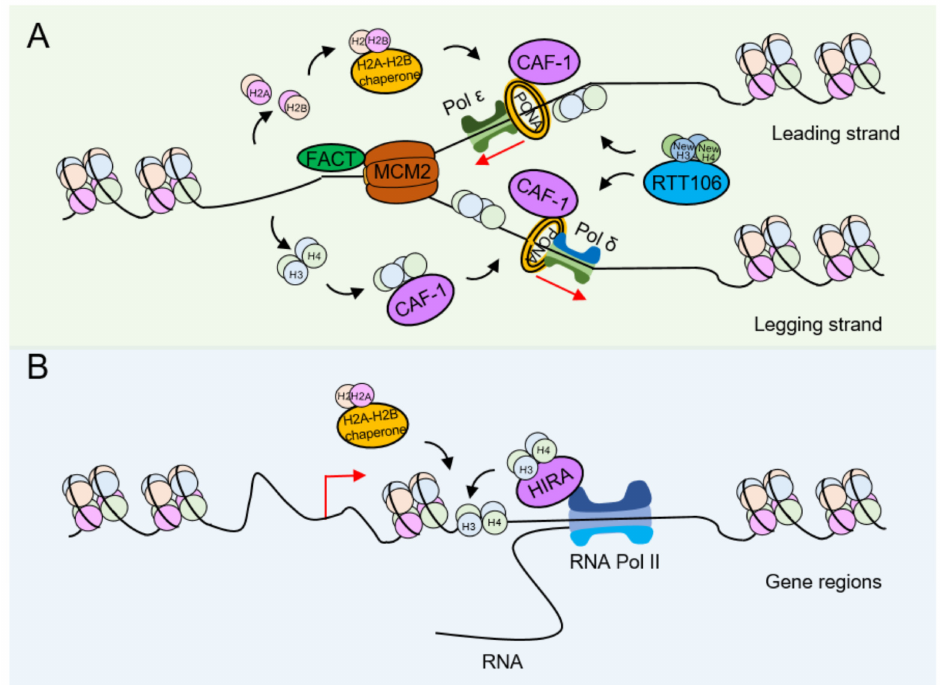
Figure 2. Diagram of RCNA and RINA. ( A ) Replication-coupled nucleosome assembly (RCNA). Nucleosomes must be disassembled to make way for DNA replication machinery. Nucleosomes are then reassembled in close concert with DNA replication on the leading and lagging strands. ( B ) Replication-independent nucleosome assembly (RINA). Many of the same core principles of nucleosome disassembly, DNA access and nucleosome assembly are likely applicable to replication- independent processes such as gene